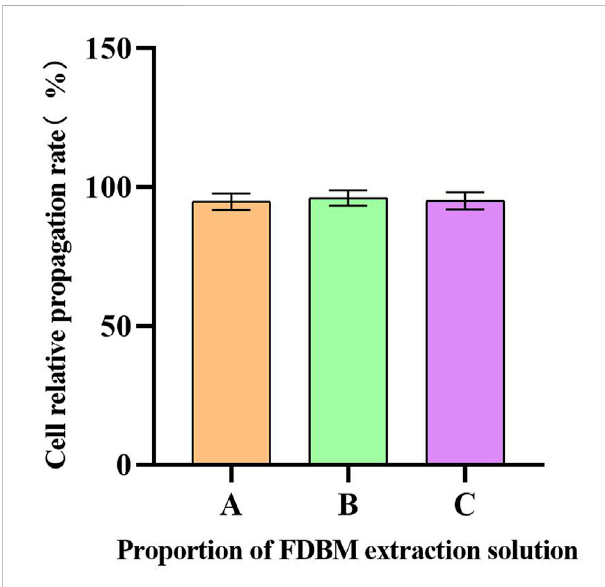
FIGURE 6 Cell proliferation rate. The horizontal coordinate is the proportion of FDBM extraction solution to the cell culture medium. A is 100%; B is 50%; C is 25%. (There was no signi fi cant difference between the three data sets.) (n = 6).